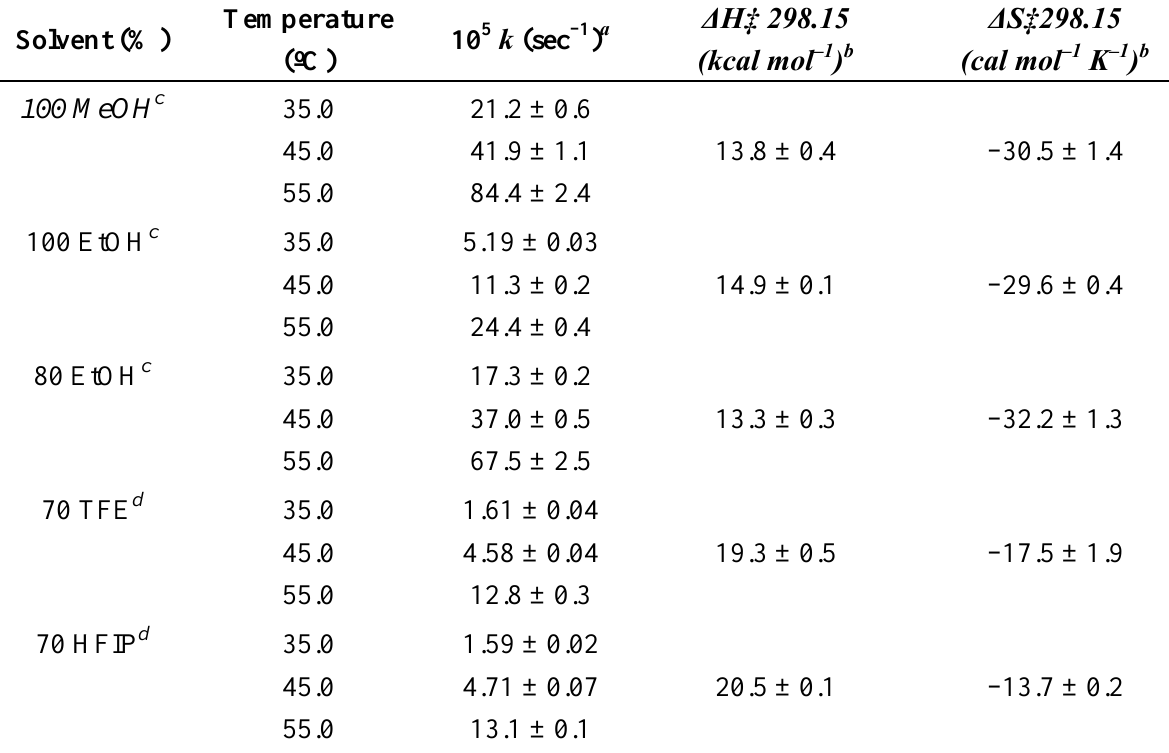
Table 2. Specific rates and activation parameters for the solvolysis of n